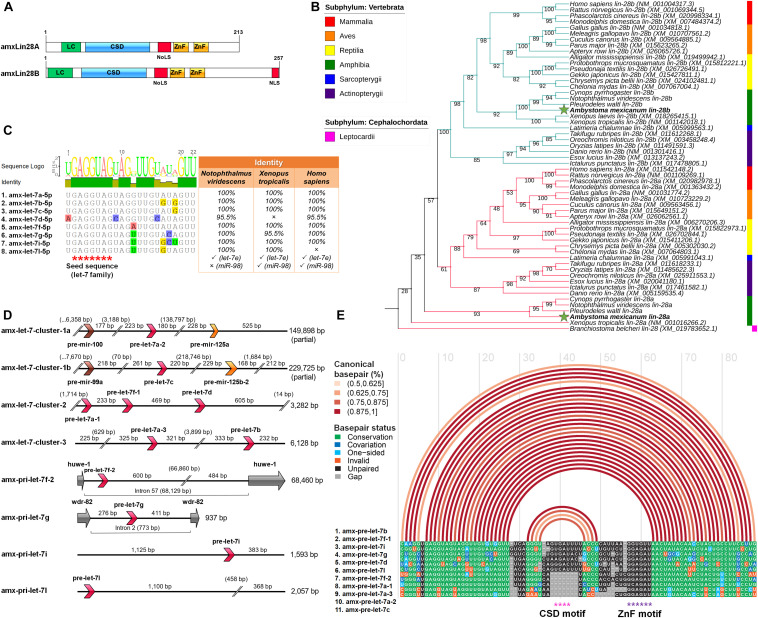
Identification and in silico analysis of members for the Lin28 and let-7 families in axolotl. (A) Domains organization scheme for canonical sequences translated of the amxLin28A and amxLin28B paralogs, where LC is N-terminal low-complexity region; CSD: S1-like cold-shock domain; NoLS: predicted nucleolar localization signal; ZnF: zinc-knuckle domain comprised by two retroviral-type CCHC zinc-fingers motifs; NLS: C-terminal nuclear localization signal present in amxLin28B only. (B) Rooted Maximum Likelihood phylogenetic tree for lin-28 coding sequences of representative vertebrate animals. Bootstrap support was determined by 10,000 replicates. Branch lengths were omitted for the best visualization of the tree. Branch colors indicate different paralogs of lin-28 and green stars highlight the lin-28 sequences of axolotl. (C) Mature let-7 microRNAs confirmed in axolotl and their percentage of sequence identity with respect to equivalent members in other tetrapods. Red asterisks mark the seed sequence region corresponding to the let-7 family. (D) Genomic organization of primary let-7 transcripts in axolotl. Orientation of the different microRNA precursors and exons are shown with directional arrows in different colors to discriminate between distinct microRNA families (pre-let-7: red arrows; pre-mir-125: orange arrows; pre-mir-100/99: brown arrows), or coding exons (gray arrows). (E) Alignment of precursor sequences of the let-7 family in axolotl. Arcs in different shades of red indicate percentages of canonical pairing between base pairs into a secondary folding structure. Asterisks in different colors mark distinct cis-motifs exposed in hairpin-type structures.